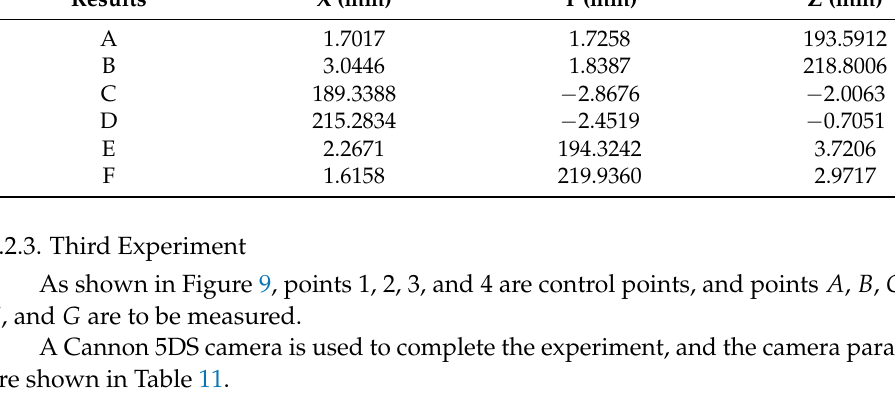
Table 11. Camera